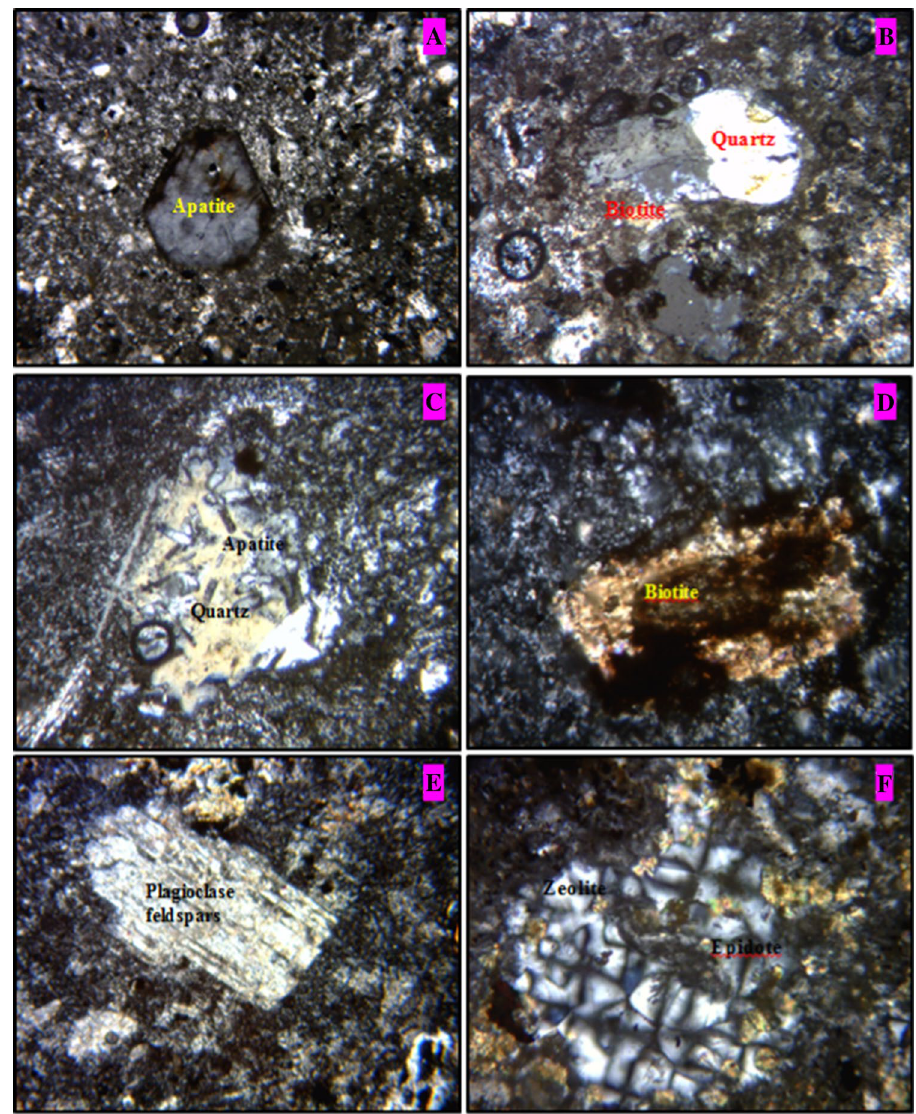
Fig. 4 Photomicrographs of rocks of the study area. A , C Apatite (100 k). B Biotite and Quartz in (100 ×). D Biotite (100 ×). E Plagioclase feldspars (50 ×). F Epidote and Zeolite (200